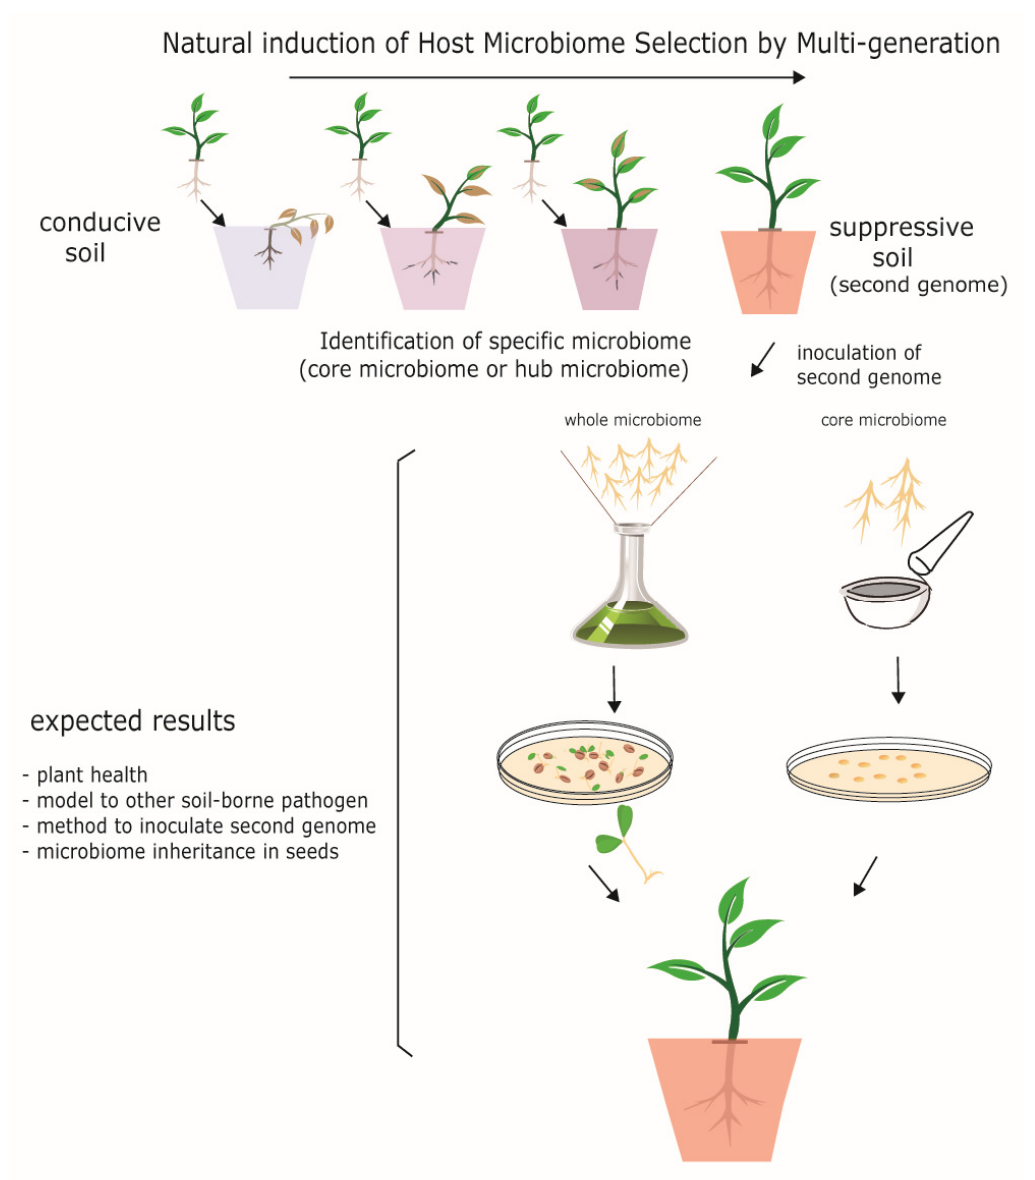
Figure 4. Engineering microbiome by host-mediated microbiome selection to plant health. The natural selection of microbiota over multiple generations can be induced by continual plant sowing in conducive inoculated soils (horizontal transmission). Using this approach, host plants can be used to recruit and self-identify desirable microorganisms that could later be used as inoculants to transfer functional core microbiota, or whole microbiota, in order to obtain healthy plants for subsequent generations (vertical transmission).